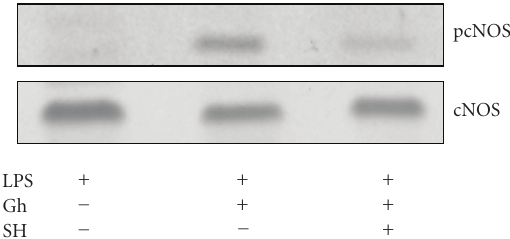
Figure 7: E ff ect of Akt inhibitor, SH-5 (SH), on ghrelin- (Gh-) induced cNOS phosphorylation in gastric mucosal cells exposed to H. pylori LPS. The cells were treated with Gh (0.5 μ g/mL) or SH (20 μ M)+Gh and incubated for 16h in the presence of 100ng/ml LPS. Cell lysates were resolved on SDS-PAGE, transferred to nitrocellulose, and probed with phosphorylation-specific cNOS (pcNOS) antibody, and after stripping reprobed with anti-cNOS antibody. The immunoblots shown are representative of three experiments.